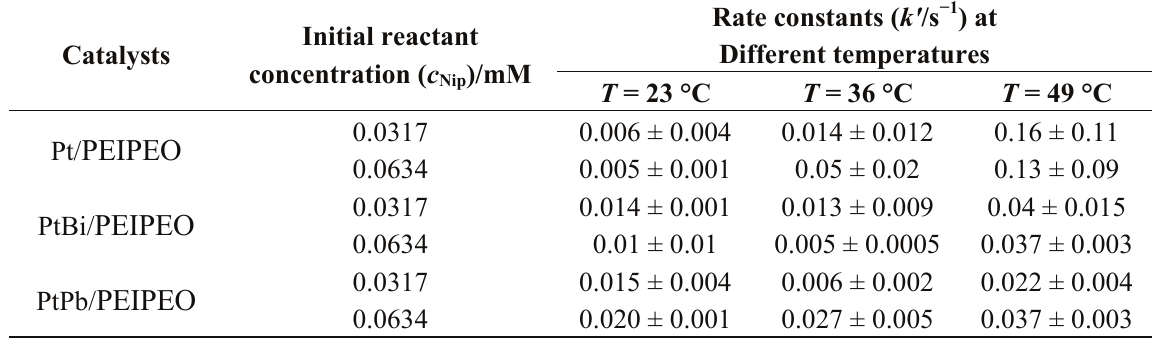
Table 3. The first-order rate constants for the reduction of 4-nitrophenol to 4-nitrosophenol using NaBH as the reducing agent and three different nanoparticles as the catalyst. All 4 reductions were performed with 1 mg of catalysts ( i.e. , 0.3 mg Pt, PtPb, PtBi NPs and 0.7 mg polymer) and a constant concentration of the reducing agent (6.196 mM NaBH reduction was measured at 23 °C, 36 °C and 49